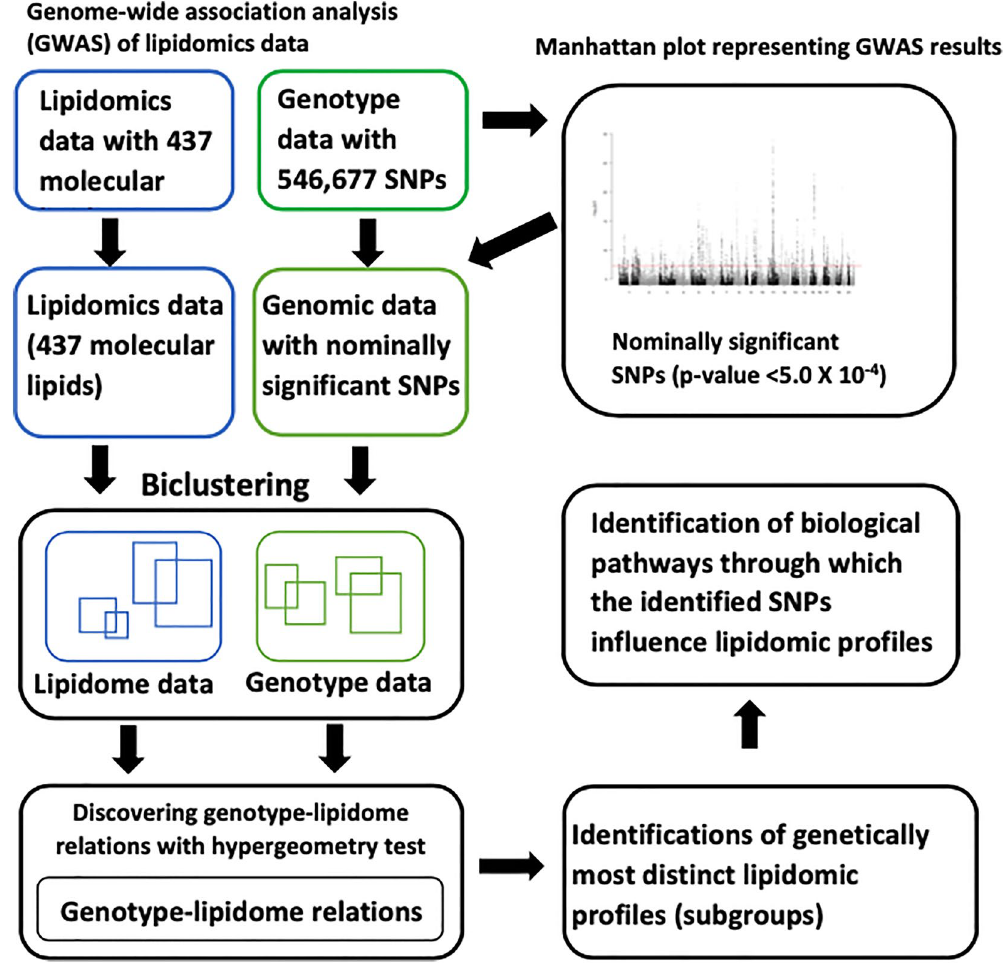
Figure 1. Phenotype-genotype many-to-many relation analysis (PGMRA)